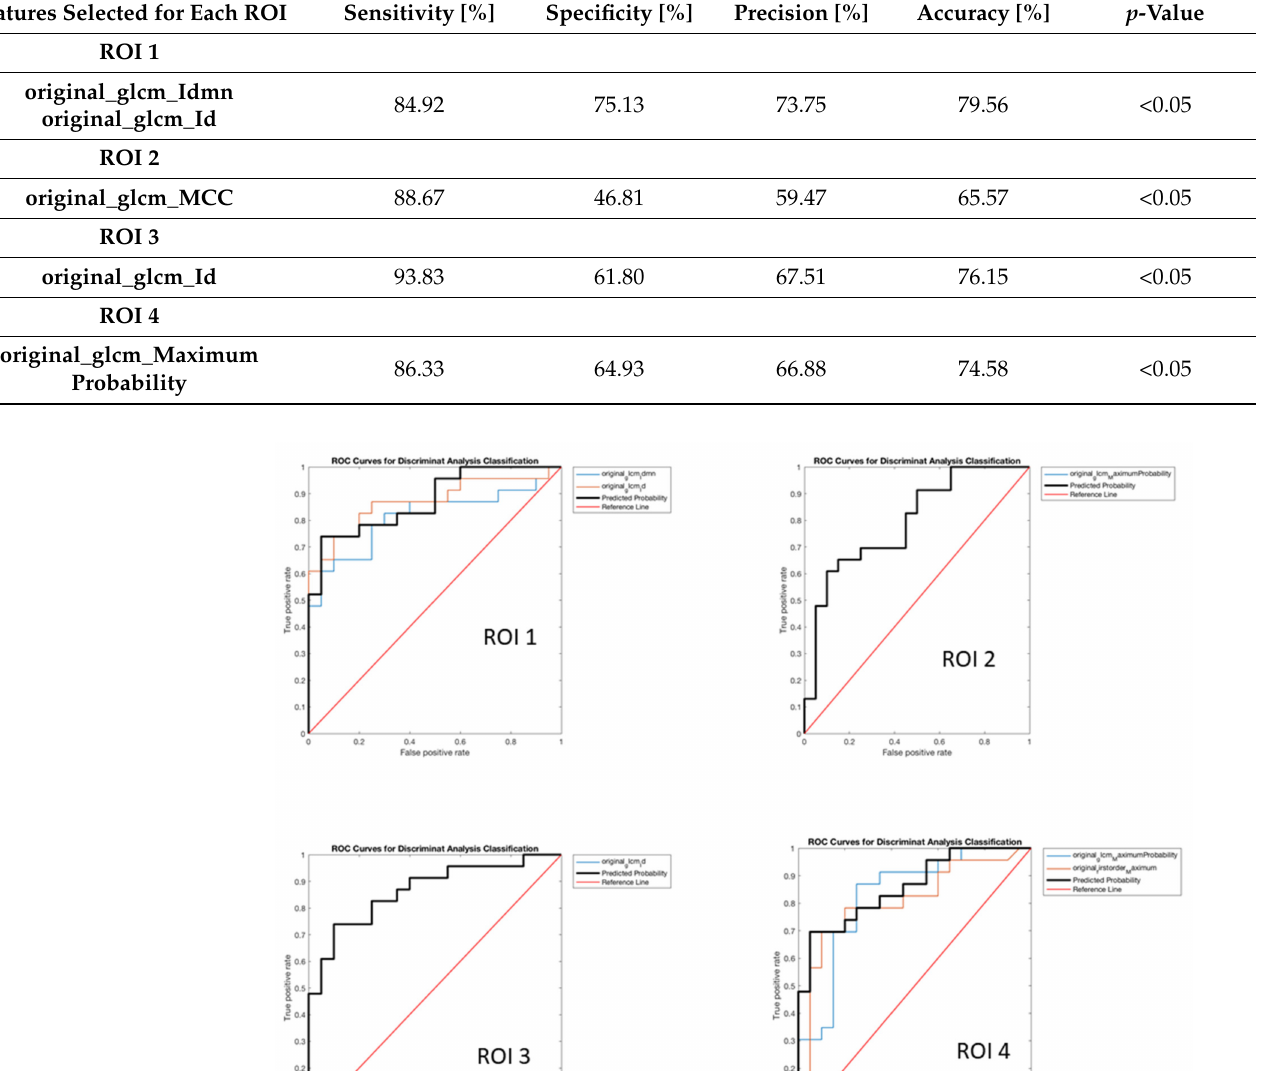
Table 3. Performances of FDG-PET derived features in the prediction of Amyloid-PET positivity.